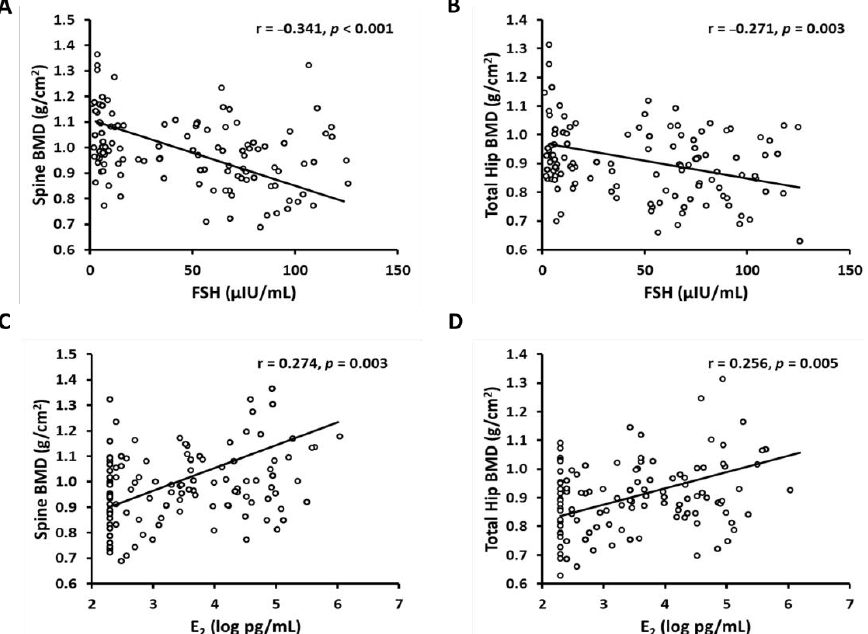
Figure 2. Associations of bone mineral density (BMD) and sex hormones. ( A ) Lumbar-spine BMD versus follicle stimulating hormone (FSH), ( B ) total hip BMD versus FSH, ( C ) lumbar-spine BMD versus estradiol (E 2 ), and ( D ) total hip BMD versus E 2 . Table 3. Correlations of bone mineral density with age, hormones, energy intake, and physical activity among all groups.